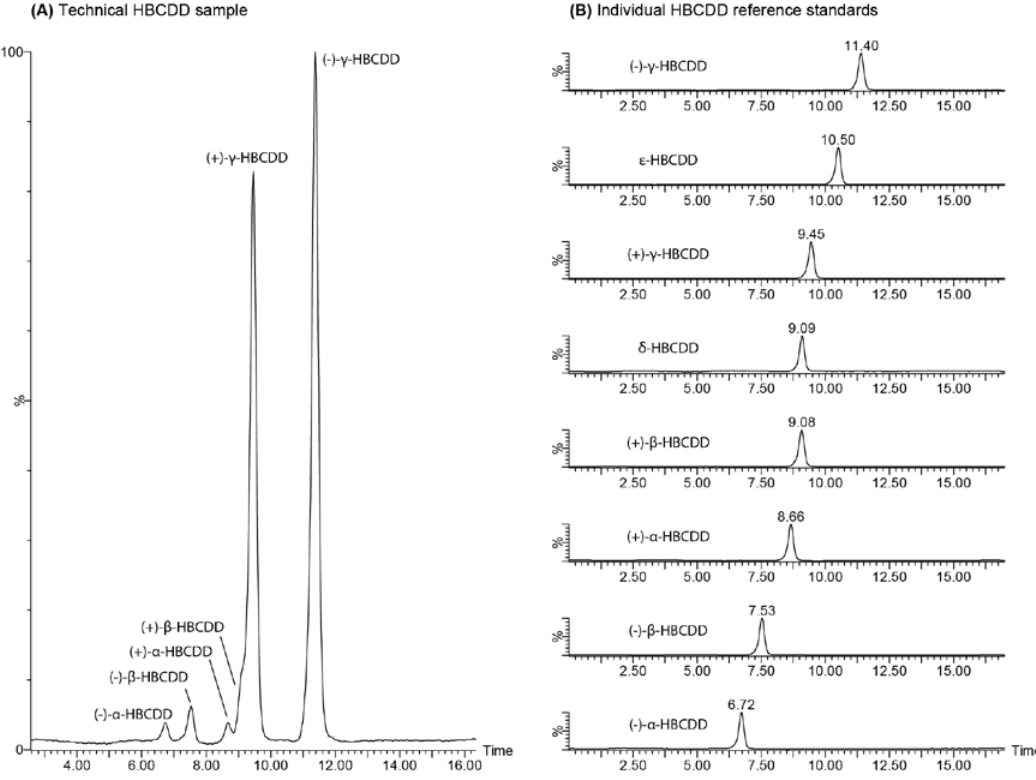
Figure 2. Analytical scale LC-MS separation of ( A ) a technical HBCDD mixture and ( B ) the isolated α-, β-, and γ-HBCDD enantiomers as well as reference standards for δ- and ε-HBCDD on a Phenomenex Nucleodex β-PM (permethylated β-cyclodextrin) stationary phase at ambient temperature using an acetonitrile/water mobile phase.